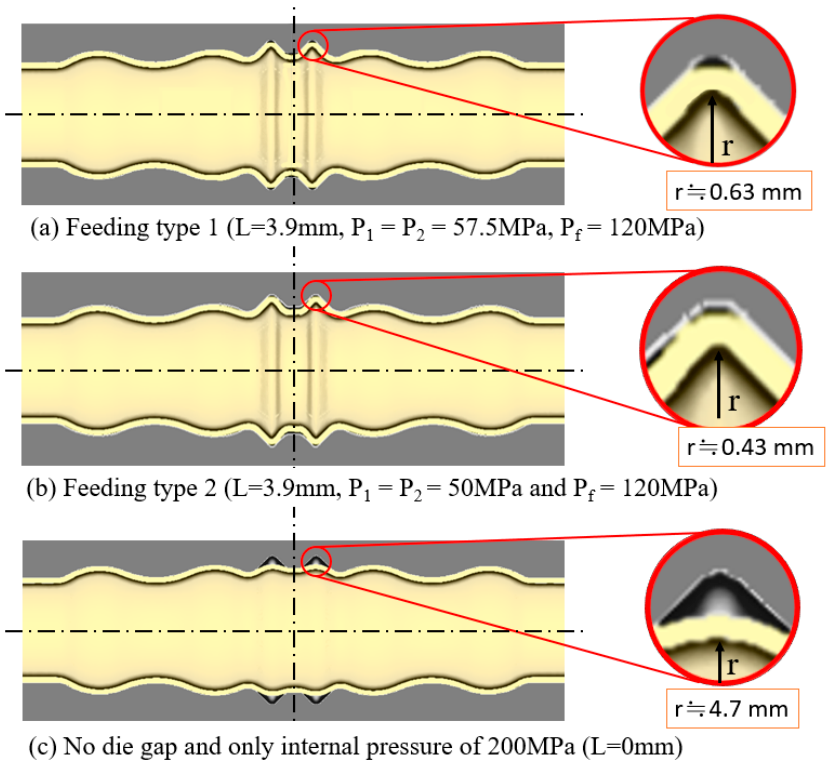
Figure 8. Comparisons of hydroformed bellows shapes with and without movable die design.